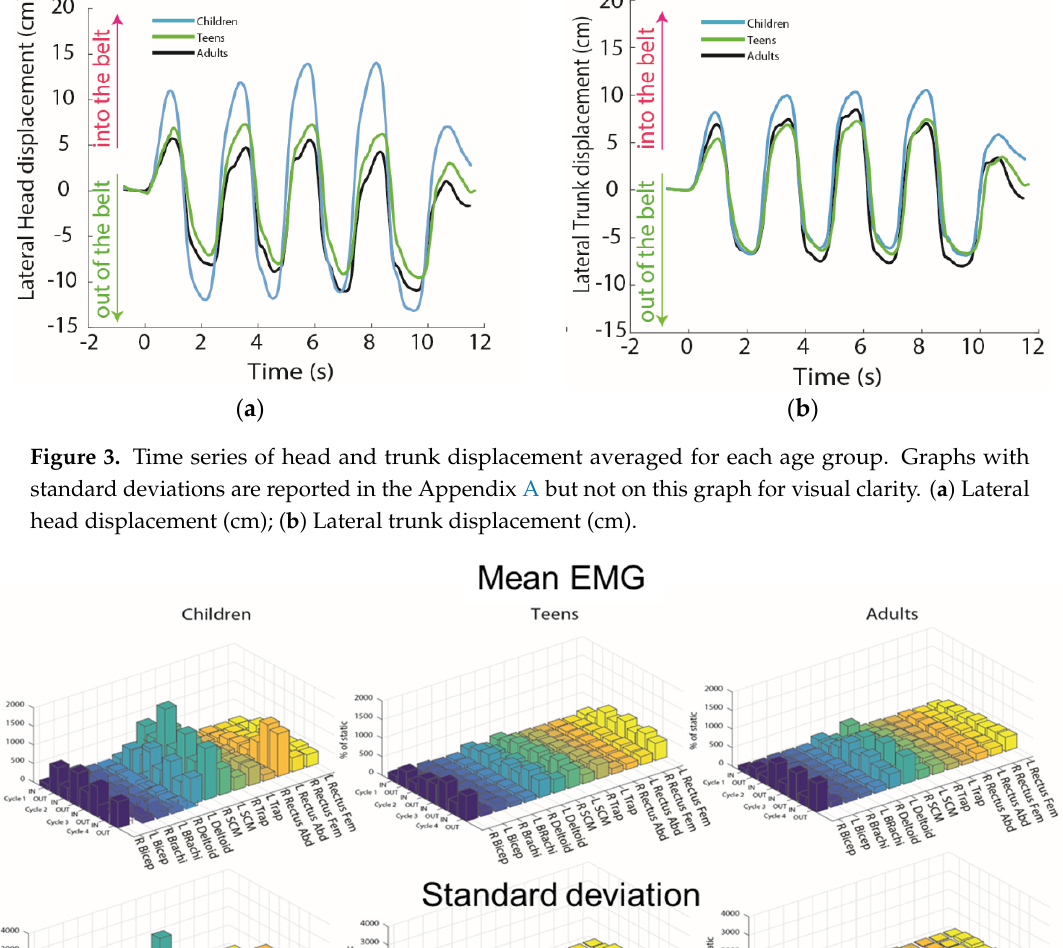
Table 3. Mean (SD) of normalized and non-normalized kinematic outcome measures: effect of cycle. Dependent measures